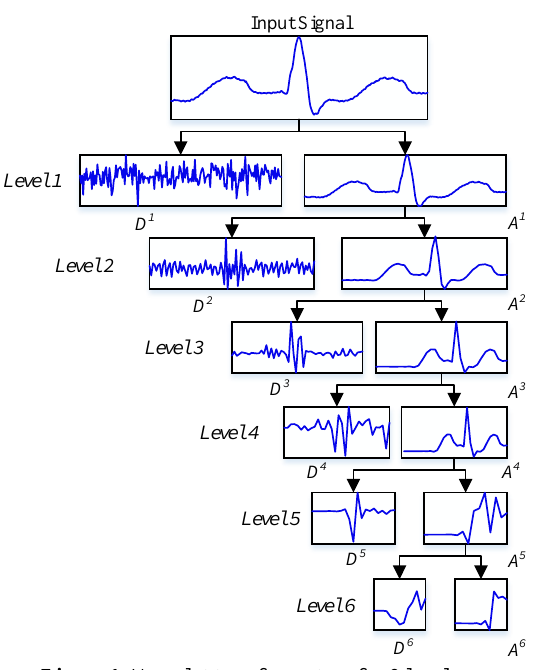
Figure 1. Wavelet transform steps for 6